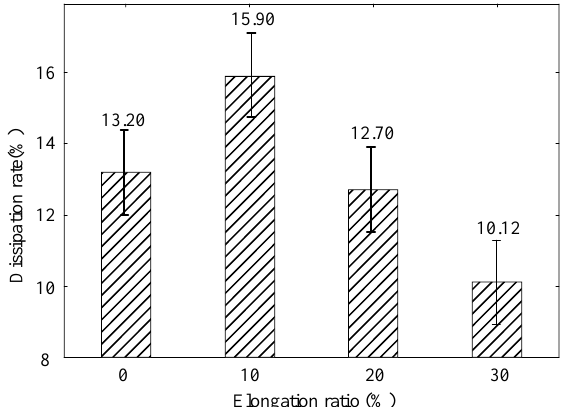
Figure 8. Decay characteristics of polyethylene surface potential at different elongation ratios.